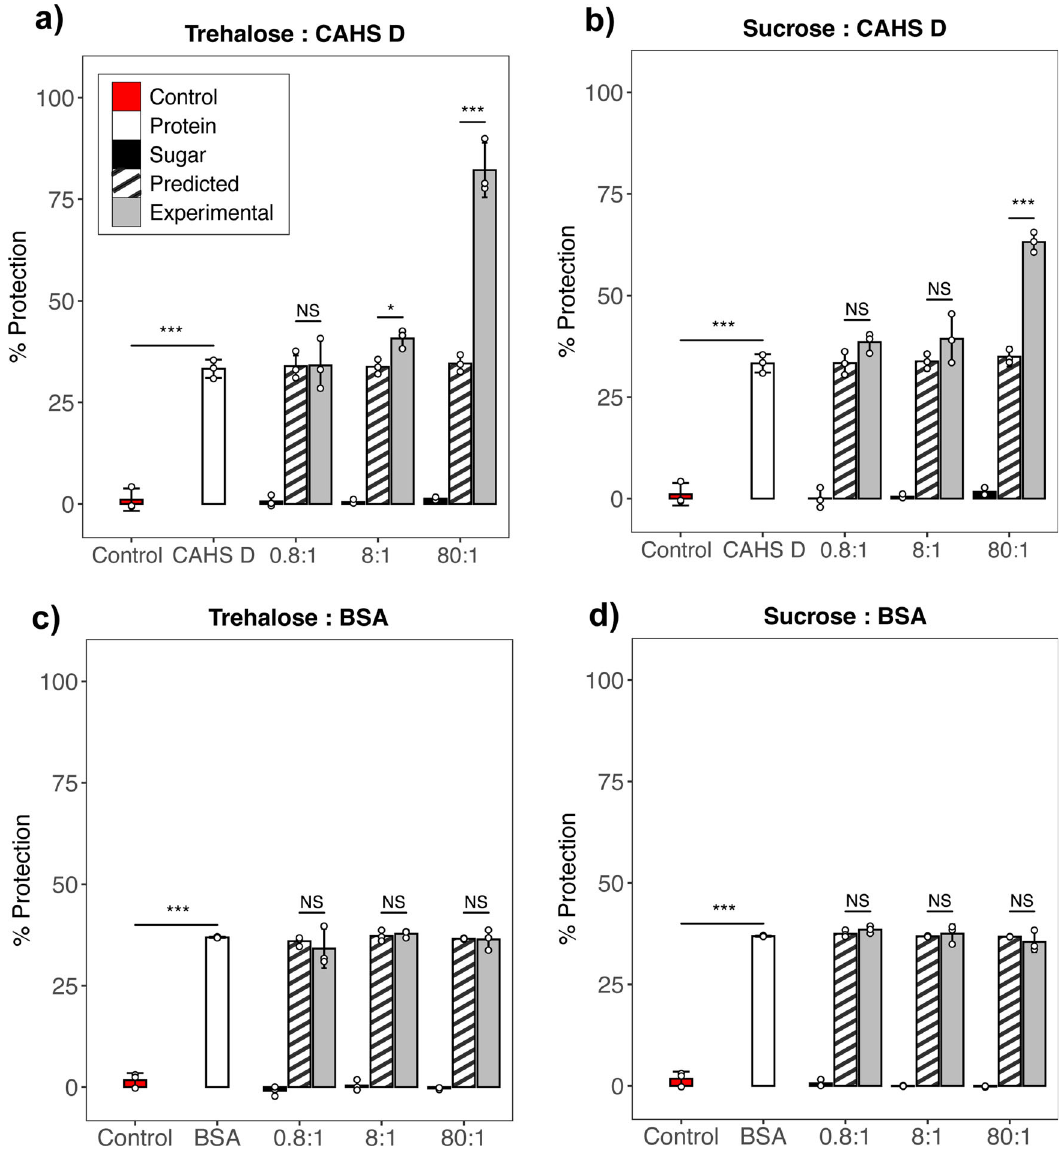
Fig. 4 Trehalose and CAHS protein confers synergistic protection at and above estimated biological ratios. Red bars represent negative controls in which no protectants were added to LDH solutions before drying. White bars represent samples in which only CAHS D was added to LDH solutions prior to drying. Black bars represent the percent protection of LDH conferred by either trehalose or sucrose. Striped bars represent the predicted additive of the sugar and the protectant (white + black bars). Gray bar represents actual experimental protection resulting from sugar and protein mixtures. Samples assayed were a Trehalose and CAHS D, b Sucrose and CAHS D, c Trehalose and BSA, d Sucrose and BSA. n = 3, one way ANOVA was used for statistical comparisons where ***, ** and * indicates p -value of <0.001, <0.01, and <0.05, respectively. Error bars = standard